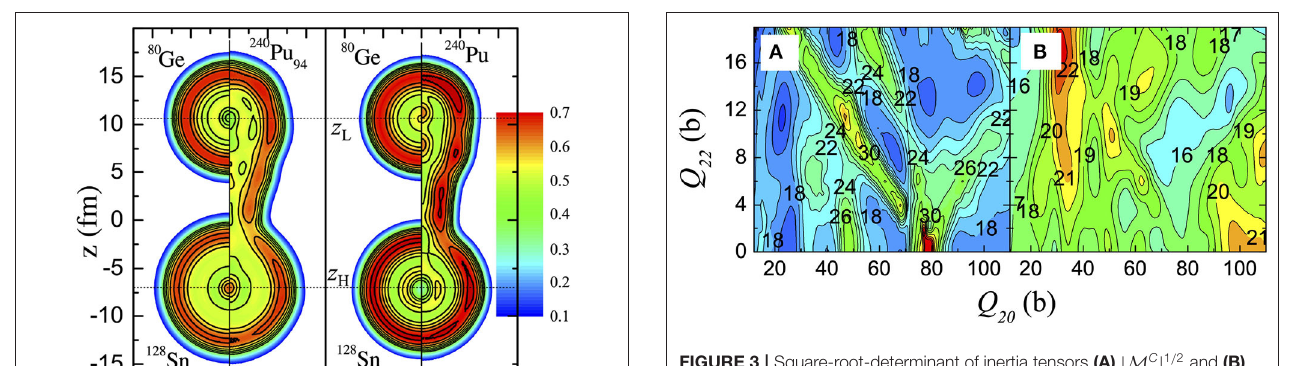
FIGURE 3 | Square-root-determinant of inertia tensors (A)